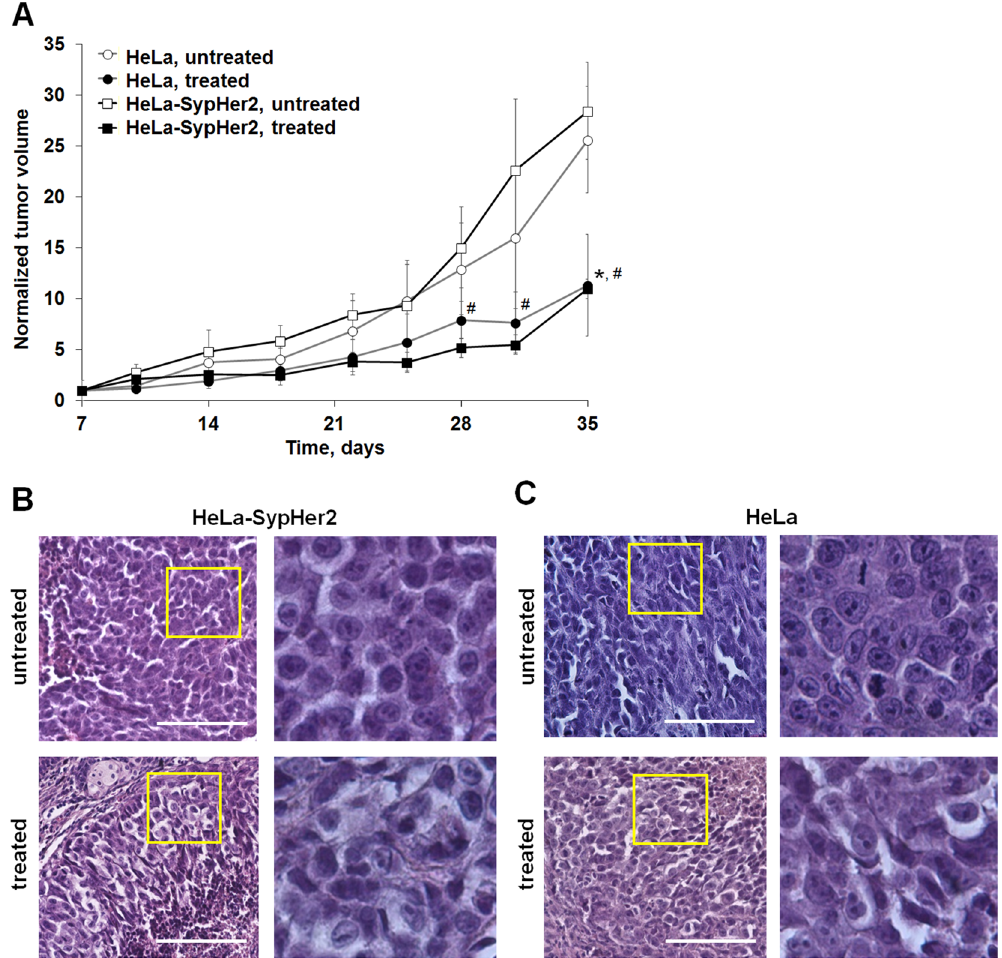
Figure 4. Effects of cisplatin on HeLa tumors in mice. ( A ) Tumor volume dynamics in response to cisplatin. Mice ( ● , ■ ) were administrated i.p. with 5 mg/kg cisplatin, totaling 11 doses, for 4 weeks, starting from day 7 after tumor challenge (day 0). Control mice ( ○ , □ ) received PBS. Mean ± SD, n = 3. Tumor volumes from individual mice were normalized to the values measured on day 7. * Statistically significant difference between treated and untreated HeLa tumors, p ≤ 0.05. # Statistically significant difference between treated and untreated HeLa-SypHer2 tumors, p ≤ 0.05. ( B , C ) Post-treatment histopathology of HeLa-SypHer2 and HeLa tumors. H&E-staining. Enlarged regions are indicated by the yellow squares on the lower-magnification panel (210 × 280 µ m, original magnification × 20). Higher-magnification images (60 × 80 µ m, original magnification × 40) are shown on the right. Bar is 100 µ